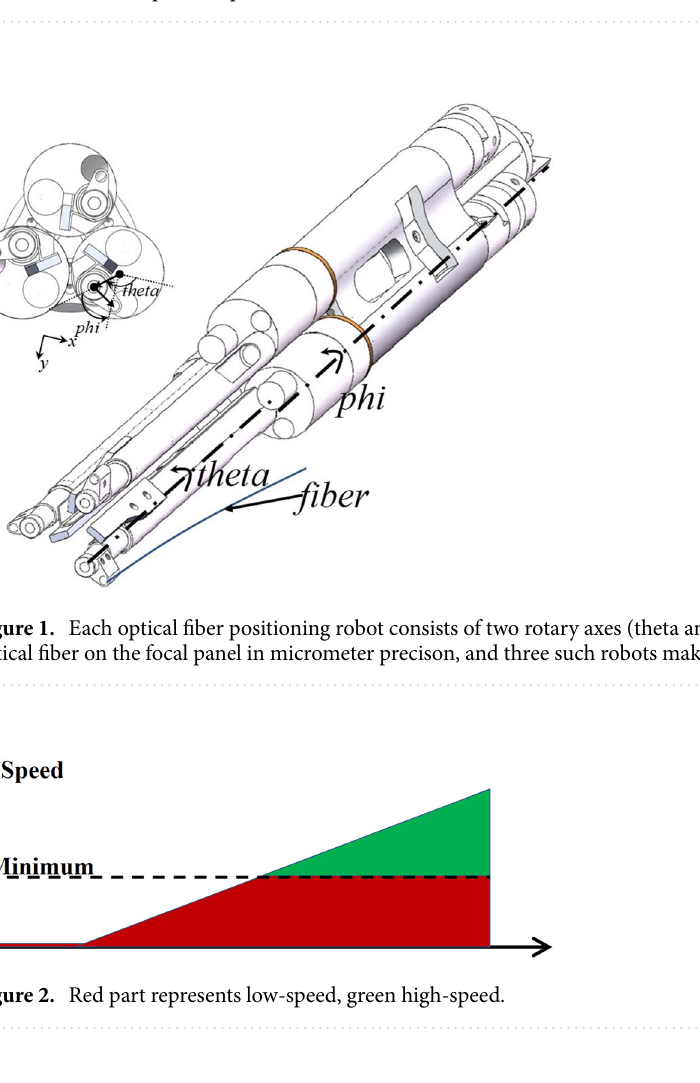
Table 1. Hollow cup motor parameter.